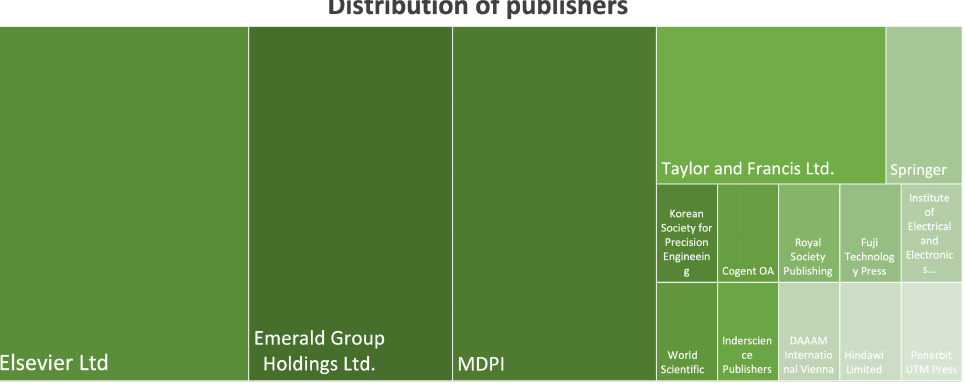
Figure 5. Distribution of